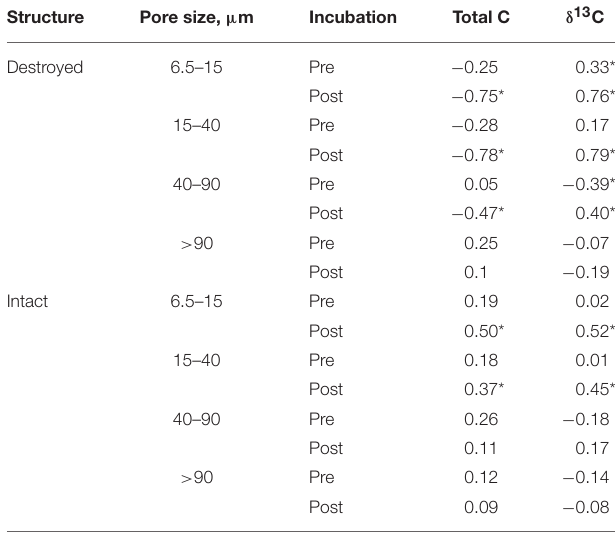
TABLE 3 | Correlation coefficients for Pre and Post soil for total C and δ 13 C with relative abundances of 6.5–15 µ m, 15–40 µ m, 40–90 µ m, and > 90 µ m pores for intact and destroyed-structure